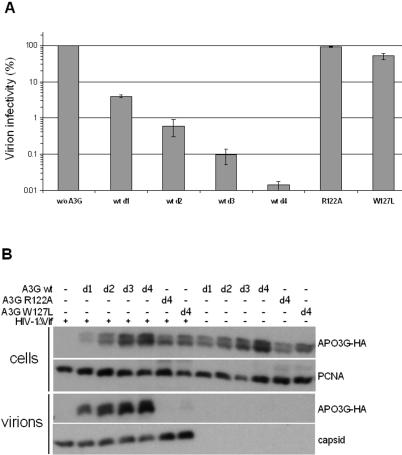
Infectivity, and packaging assay of novel defective huAPOBEC3G mutants.Panel A. Δ Vif HIV-1 particles were produced in presence of different doses of wt APOBEC3G-HA (A3G), or with the highest dose of the R122A and W127L mutants of APOBEC3G-HA. The infectivity of these particles was determined by titration on P4.2 indicator cells. The doses d1 to d4 of APOBEC3G correspond respectively to a molar ratio of APOBEC3G-HA plasmid to virus plasmid of 0.6∶1, 1.3∶1, 2.7∶1 and 5.5∶1. The graph is made from one duplicate experiment, and is representative of a total of at least 4 independent duplicate experiments. Panel B. The presence of wt APOBEC3G-HA or the R122A and W127L mutants in ΔVif HIV-1 virions was assessed by western blot. The PCNA and capsid western blots serve to check for consistent loading of cellular and virion extracts, respectively. Representative of at least two independent experiments.